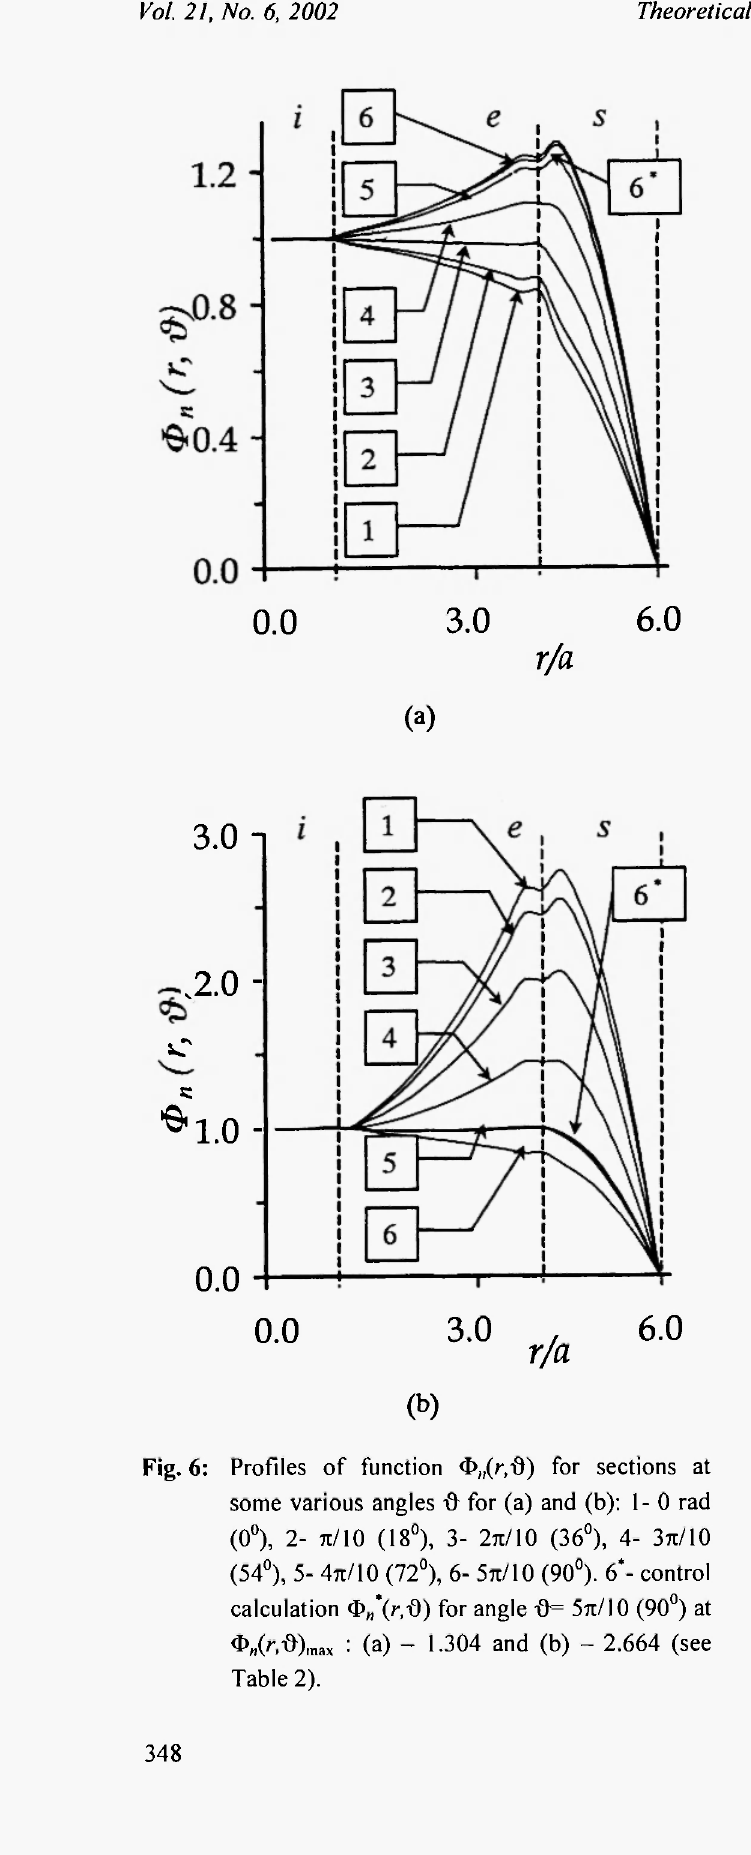
Fig. 6: Profiles of function Φ„(>,"9) for sections at some various angles ϋ for (a) and (b): 1 - 0 rad (0°), 2- π/10 (18°), 3- 2π/10 (36°), 4- 3π/10 (54°), 5- 4π/10 (72°), 6- 5π/10 (90°). 6*- control calculation 0„V,f>) for angle ϋ= 5π/10 (90°) at Φ„(>",θ), ΜΧ : (a) - 1.304 and (b) - 2.664 (see Table